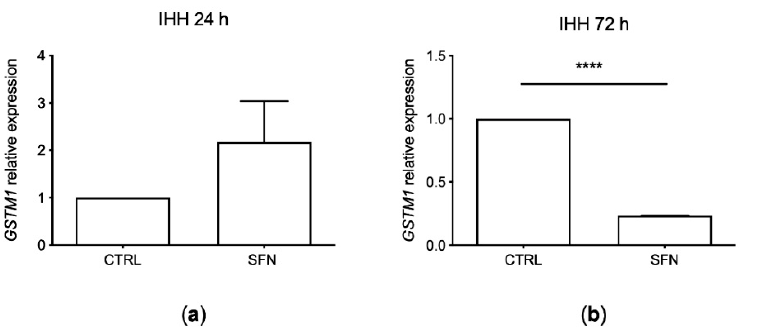
Figure 4. GSTM1 expression in IHH cell line treated with sulforaphane (SFN, 10 µM) for 24 h ( a ) and 72 h ( b ). Data are shown as means and C.I. of three representative experiments and reported evaluating 2 −ΔΔ Ct values, using untreated cells as calibrator (CTRL) and beta-actin housekeeping gene as reference. ****: p < 0.001, one way ANOVA IHH exposed to SFN vs. untreated CTRL IHH cells.